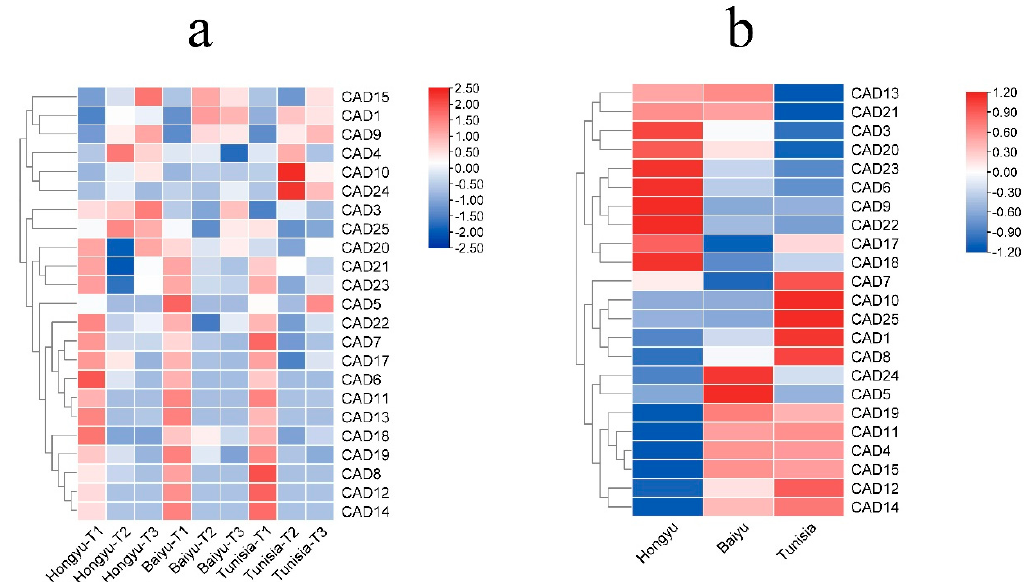
Figure 6. ( a ) Expression patterns of PgCAD . T1-T3 correspond to 40 days after anthesis, 80 days after anthesis, and 120 days after anthesis. ( b ) Expression patterns of different cultivars at T1. The scale on the left of the picture represents expression levels, with red indicating high expression and green indicating low expression.